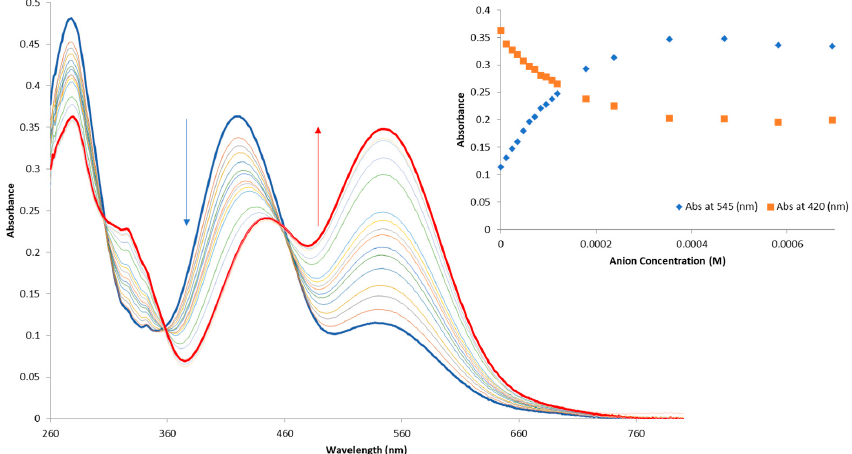
Figure 7. Changes in the UV/Vis spectrum of SN2 (12 µM) with increasing TBA sulphate concen- tration in DMSO. Inset: Plot of the change in absorbance at 420 nm ( orange ) and 545 nm ( blue ) as a function of TBA SO 4 concentration.